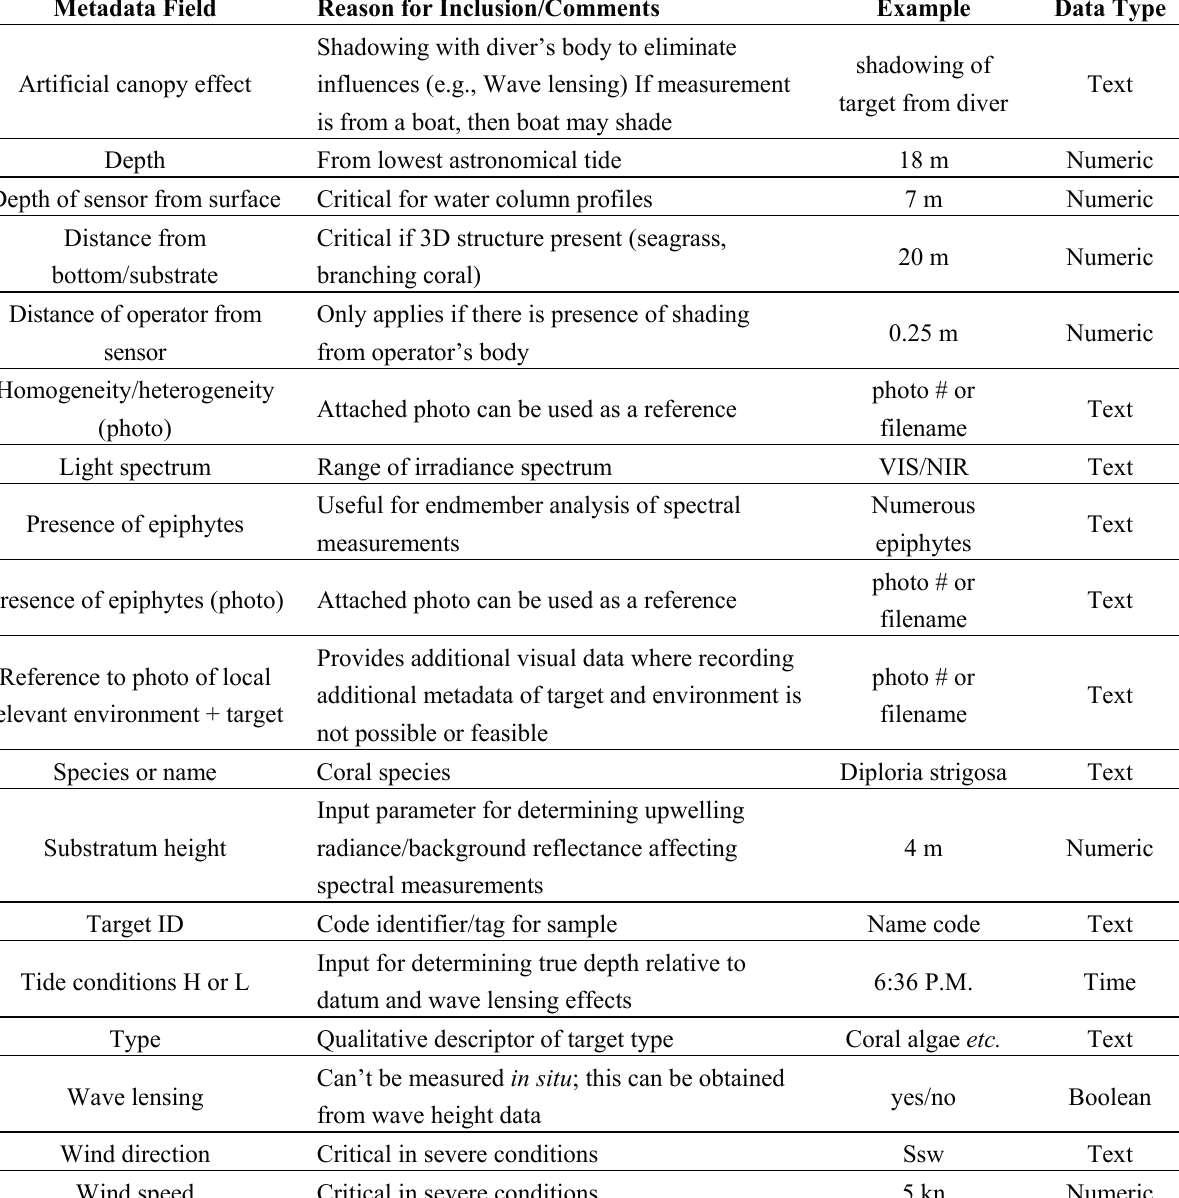
Table 4. Critical metadata for in situ benthic reflectance